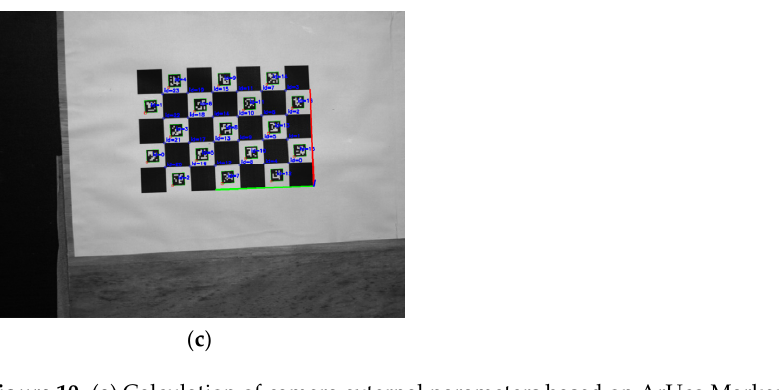
Figure 11. Hand–eye calibration uncertainty: ( a ) x coordinate reprojection uncertainty; ( b ) y coordi- nate reprojection uncertainty; and ( c ) z coordinate reprojection uncertainty .